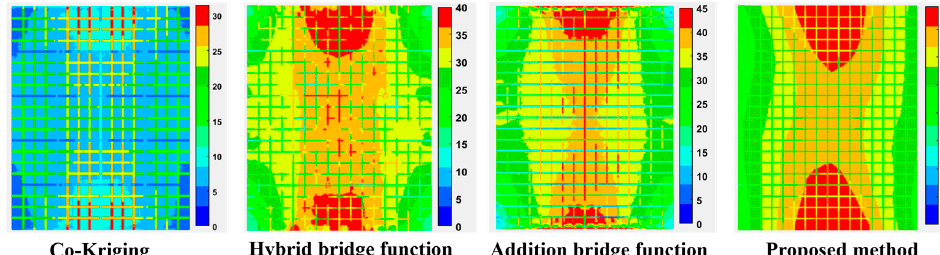
Figure 8. Mises stress field diagrams of various digital twin models for the hierarchical stiffened plate at 18 kN.